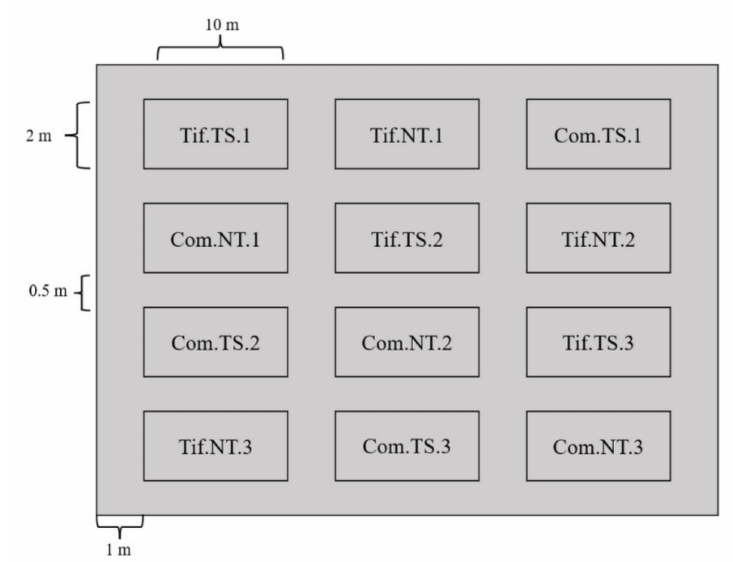
Figure 2. Sketch map of treatments. Tif.TS, Tifgreen bermudagrass with traffic treatment; Tif.NT, Tifgreen bermudagrass with non-traffic treatment; Com.TS, Common bermudagrass with traffic treatment; Com.NT, Common bermudagrass with non-traffic